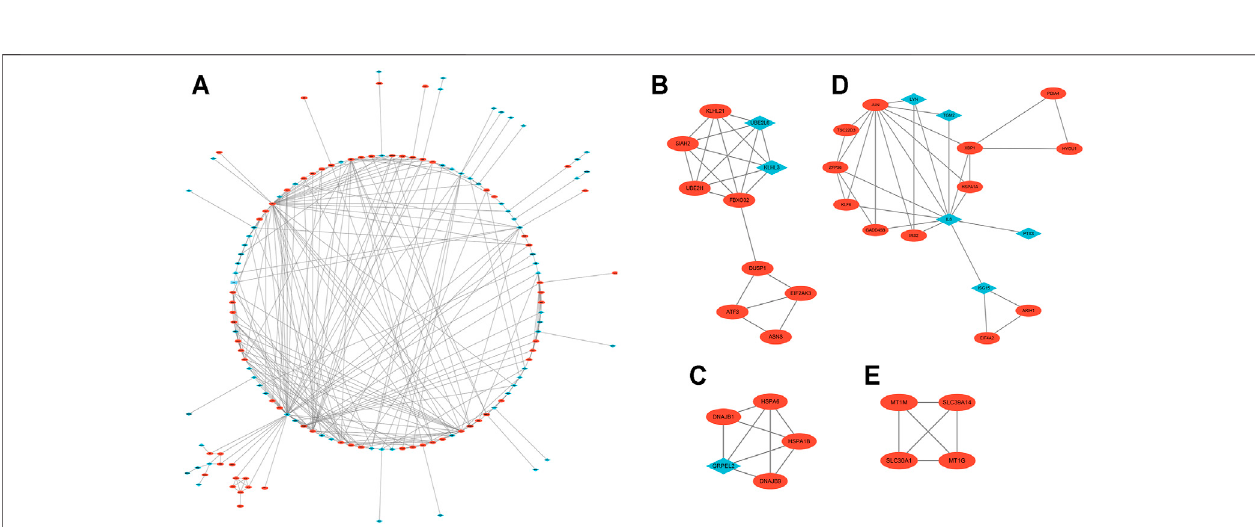
FIGURE 5 | The PPI network and two cluster modules were extracted by mCODE. (A) The PPI network of DEGs in GSE23289, which comprised 167 nodes and 334 edges. Each node represents a protein, while each edge between the two proteins shows a protein – protein correlation. The up- or downregulated genes are highlightedasredcirclesandbluediamonds,respectively. (B) ClustermCODE1consistsof10nodesand21edges.mCODEscore (cid:1) 4.667.KLHL21istheseedgenein thissubnetwork. (C) ClustermCODE2includes fi venodesandnineedges.mCODEscore (cid:1) 4.5.DNAJB9istheseedgeneinthissubnetwork. (D) ClustermCODE 3 includes four nodes and six edges, MT1M is the seed gene, score (cid:1) 4. (E) Cluster mCODE 4 includes 17 nodes and 31 edges, ZFP36 is the seed gene, and score (cid:1) 3.882).